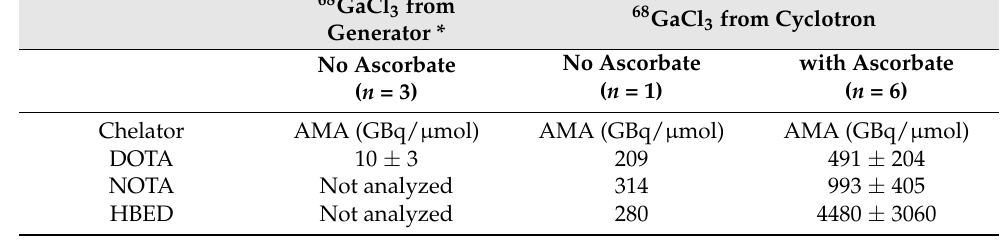
Table 1. Apparent molar activity, AMA, results from titrations with DOTA, NOTA, and HBED chela- tor. * For comparison, corresponding results with DOTA from the generator were taken from [13].